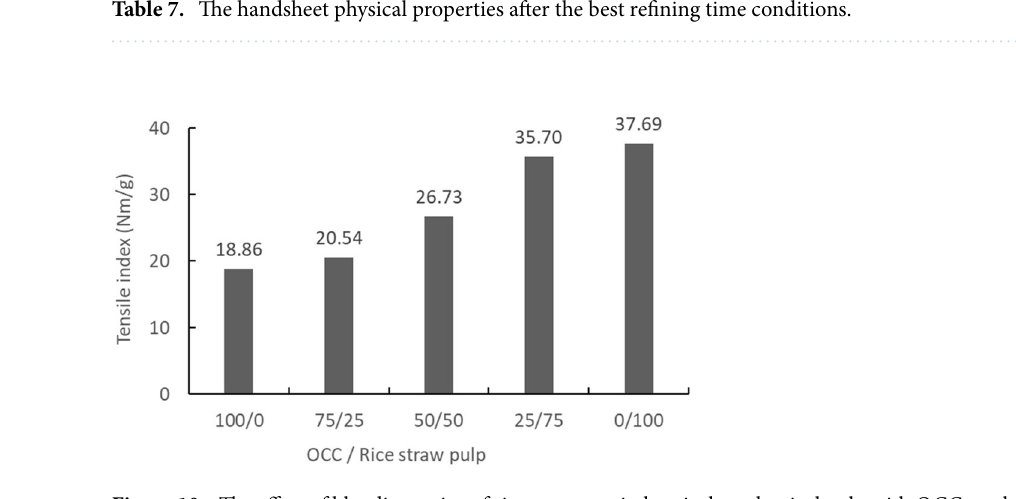
Figure 10. The effect of blending ratios of rice straw semi-chemical mechanical pulp with OCC on the tensile indices of the handsheets (expanded experiments).